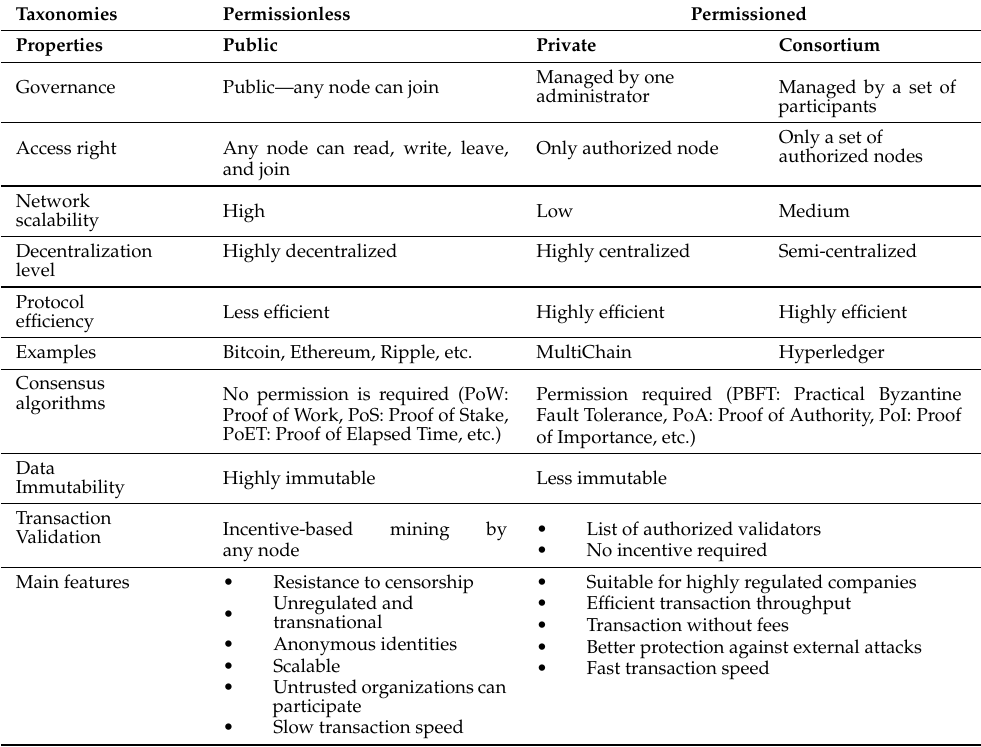
Table 2. Different features of blockchain